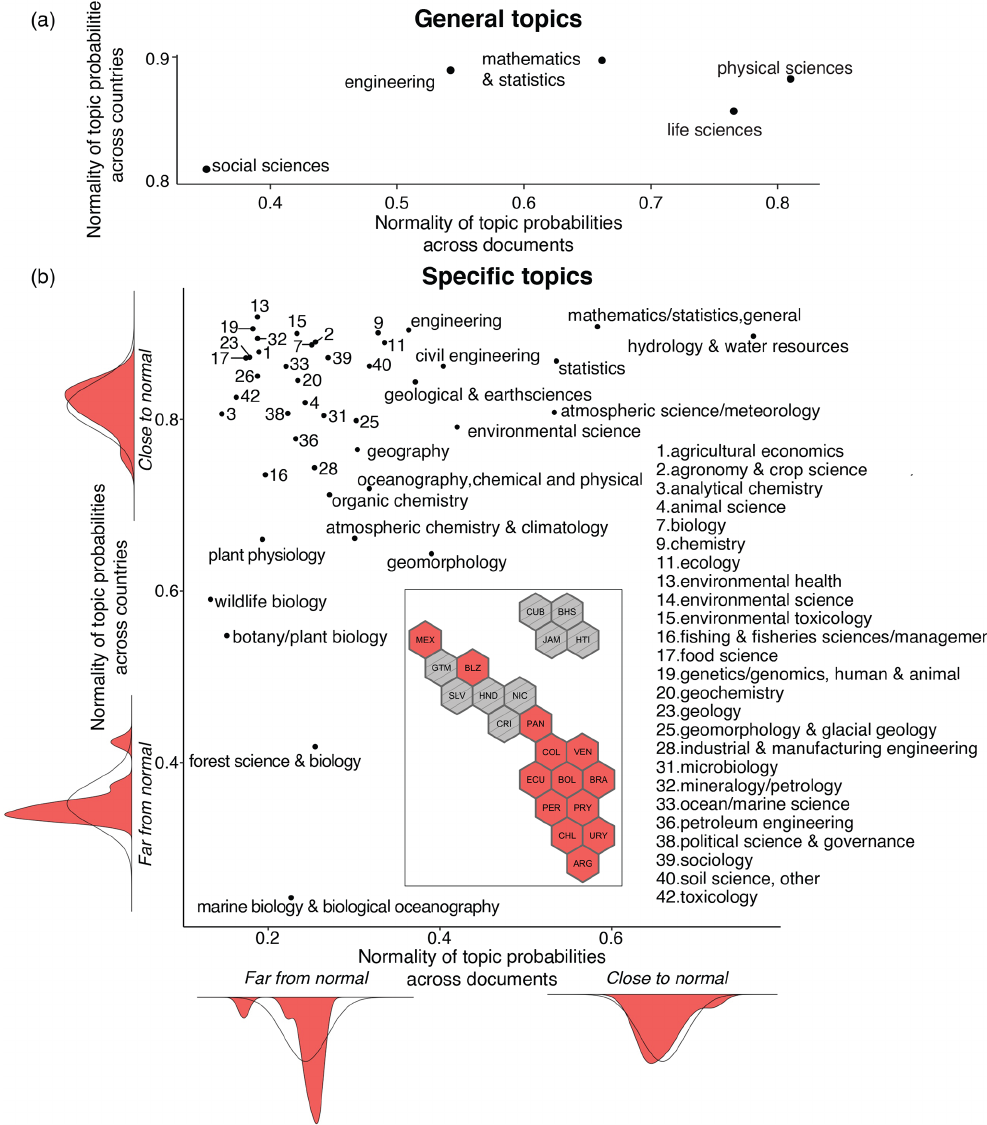
Figure 7. Normality of research topics for (a) general topics and (b) specific topics. Inset shows the countries excluded from the analysis